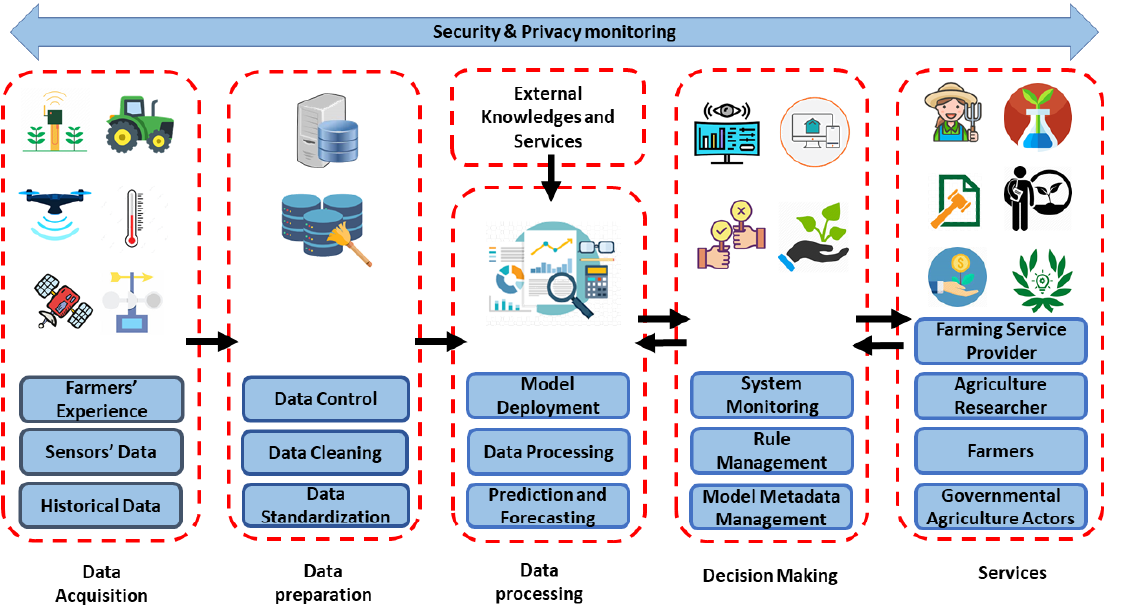
Figure 1. Smart farming components that facilitate integration, processing, and use of farm data.